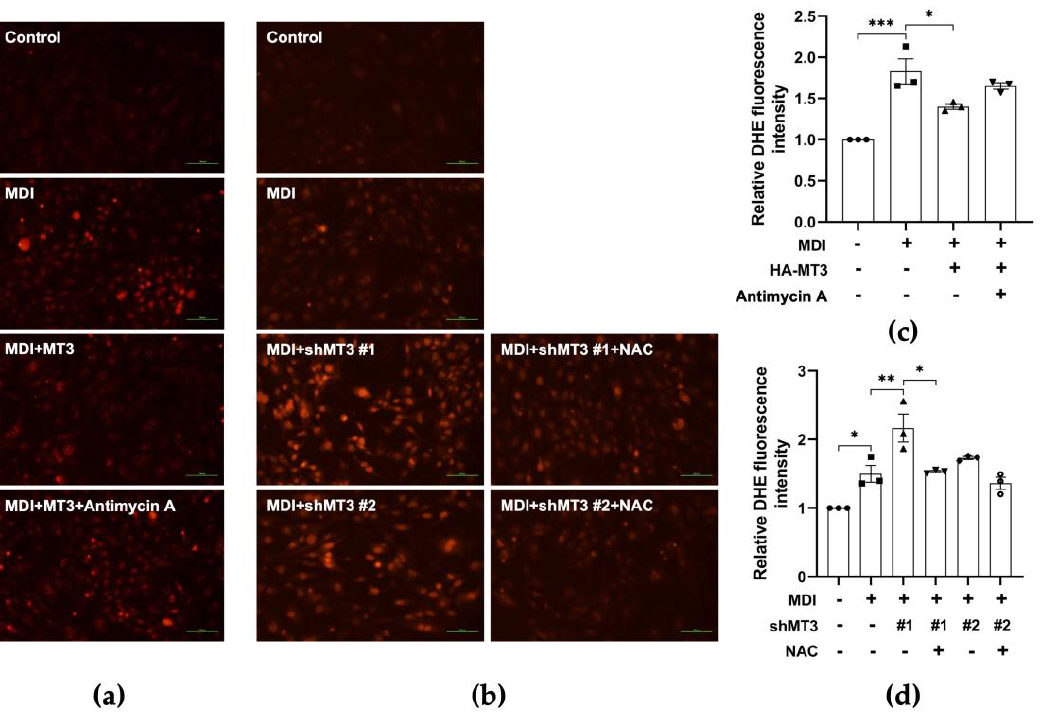
Figure 7. MT3 impedes ROS production in the early stages of 3T3 − L1 adipocyte differentiation. ( a , b ) 3T3 − L1 cells were transfected with HA − MT3 plasmid or shMT3 plasmid (0.2 µ g) prior to contact inhibition and cultured in differentiation medium with 25 nM antimycin A or 7.5 mM NAC for 12 h. ROS levels are measured by DHE assay. Representative images of 3T3-L1 adipocytes were captured at 200 × magnification. Scale bar = 100 µ m. MDI, a mixture of 3-isobutyl-1-methylxanthine,